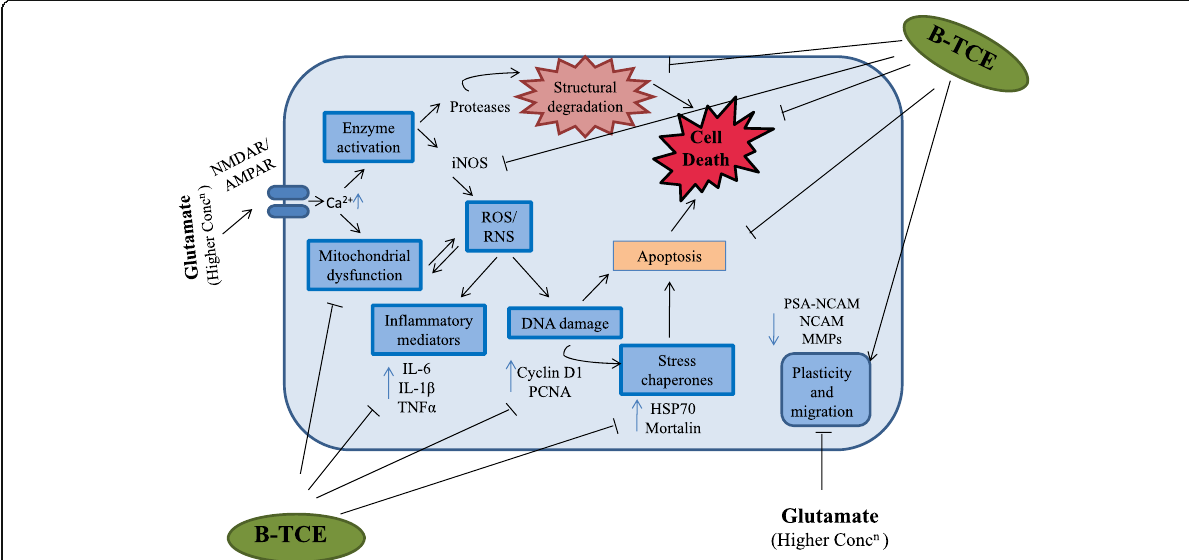
Fig. 7 Representative graphical image presenting the underlying mechanism of glutamate-induced excitotoxicity and how B-TCE pretreatment protects primary cerebellar neurons by modulating the expression of different molecular effectors. Overstimulation of glutamate receptors induced rise in intracellular calcium which leads to mitochondrial dysfunction and activation of enzymes which further results in ROS/RNS generation and structural degradation of neurons. ROS/RNS induce upregulation of inflammatory mediators, DNA damage and stress chaperones thus causing apoptosis and neurodegeneration. In the present study B-TCE pretreatment inhibited glutamate-induced structural degradation (morphometric studies, MAP-2, GAP-43, NF200), mitochondrial dysfunction (Mitotracker green FM), suppressed NO generation (iNOS), secretion of pro-inflammatory cytokines (TNF- α , IL-6 and IL-1 β ), DNA damage (Cyclin D1 and PCNA) and stress proteins expression (HSP70 and Mortalin), thus inhibited apoptosis induction and neurodegeneration. B-TCE also promoted neuronal plasticity and migration (PSA-NCAM, NCAM